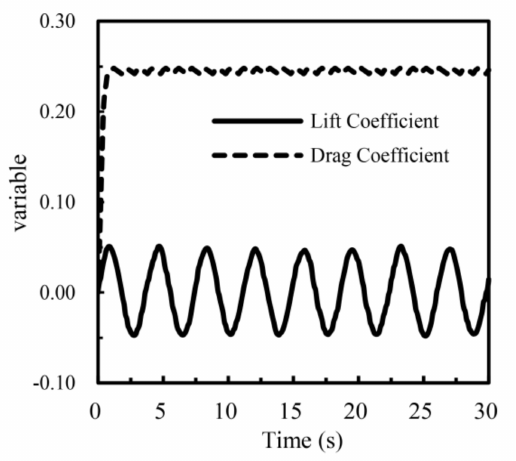
Figure 12. The time history of the C l and C d of the TS–tower.